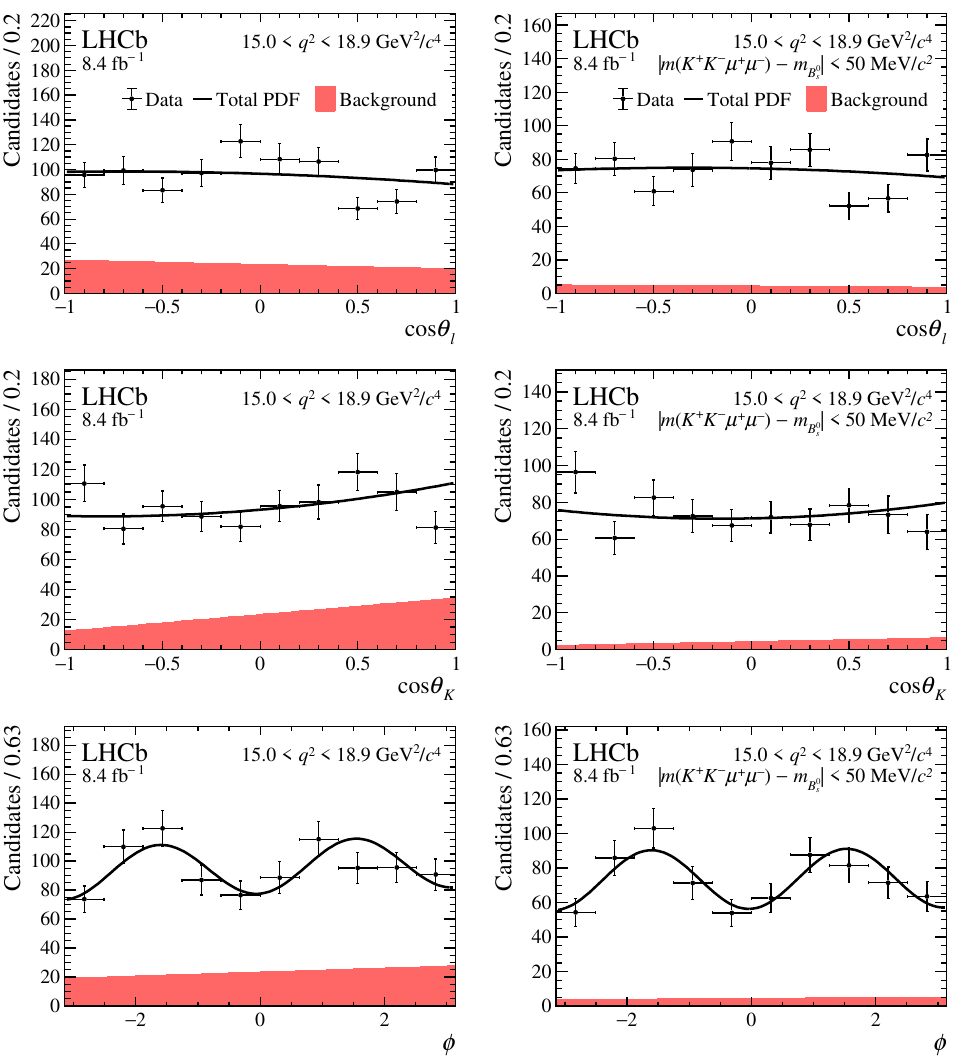
Figure 11 . Projections in the region 15 . 0 < q 2 < 18 . 9 GeV 2 /c 4 for the angular distributions of the combined 2011–2012, 2016 and 2017–2018 data sets. The data are overlaid with the projection of the combined PDF. The red shaded area indicates the background component and the solid black line the total PDF. The angular projections are given for candidates in (left) the entire mass region used to determine the observables in this paper and (right) the signal mass window ± 50 MeV/ c 2 around the known B 0 s